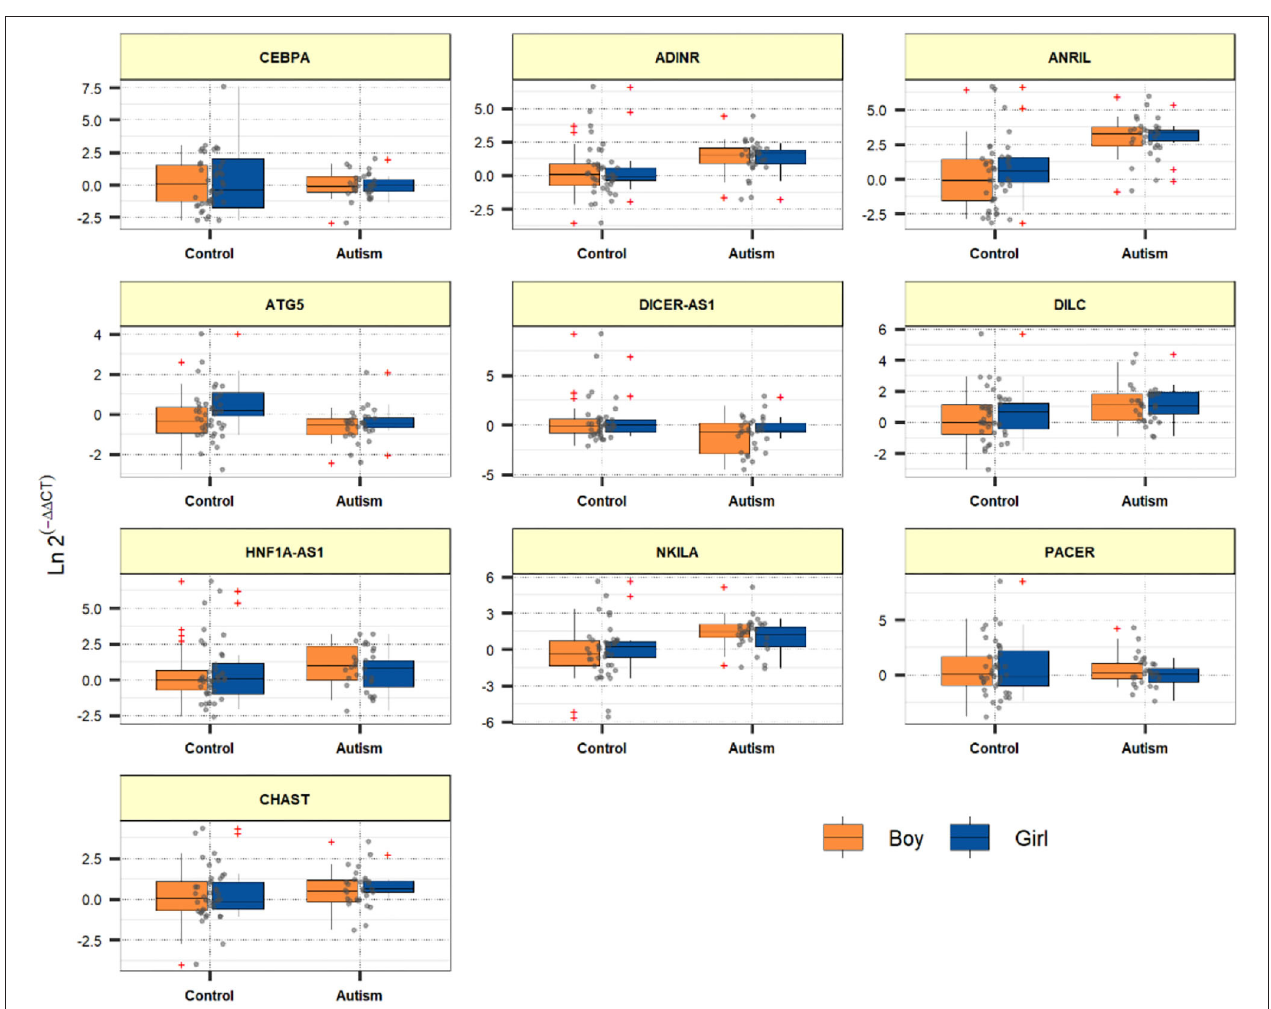
FIGURE 1 | Relative levels of assessed genes among ASD children and healthy